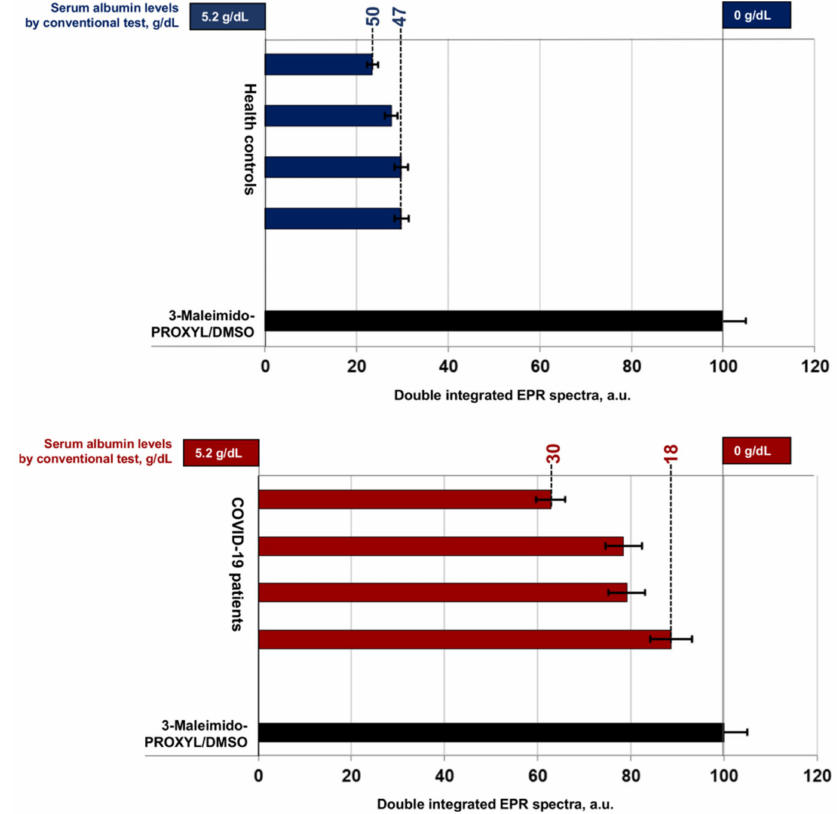
Figure 2. Double integrated EPR spectra of 3-Maleimido-PROXYL radical presented as percent value of control: 3-Maleimido-PROXYL/DMSO without serum (in black); healthy volunteers (in blue); in patients with COVID-19 (in